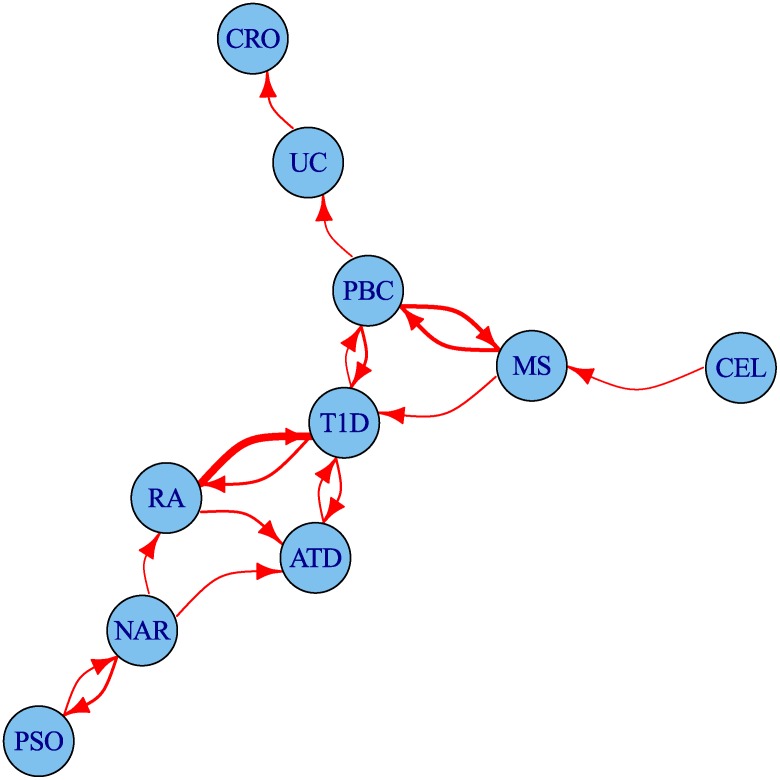
Network of degree of pleiotropy between phenotypes.An arrow runs from vertex i to vertex j if and only if by conditioning on p < 5 × 10−6 for the conditional phenotype j we can increase the threshold for significance for the p value for the principal phenotype i from 5 × 10−8 to 4 × 10−7 or greater. Edges are thickened if the cutoff could be increased more than this. The threshold 4 × 10−7 was selected as the minimum value for which the network is weakly connected; that is, having an arrow to or from each edge.